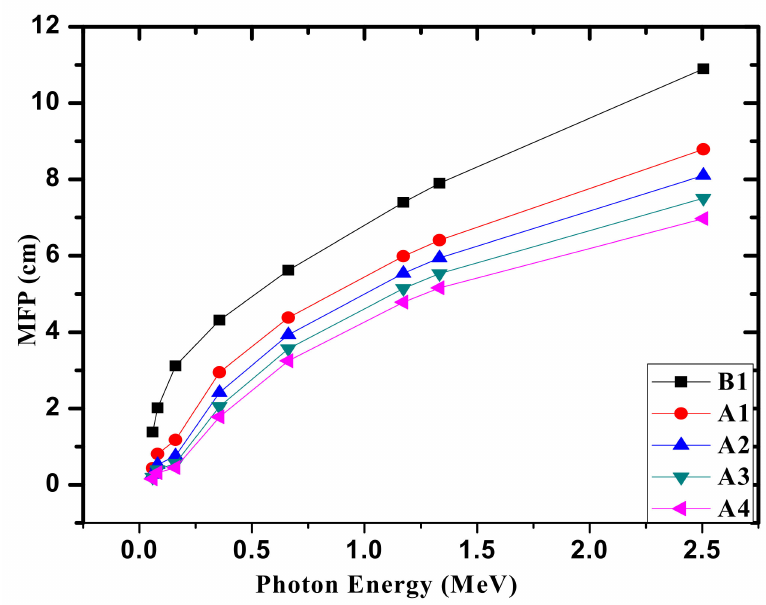
Figure 5. The MFP for the fabricated